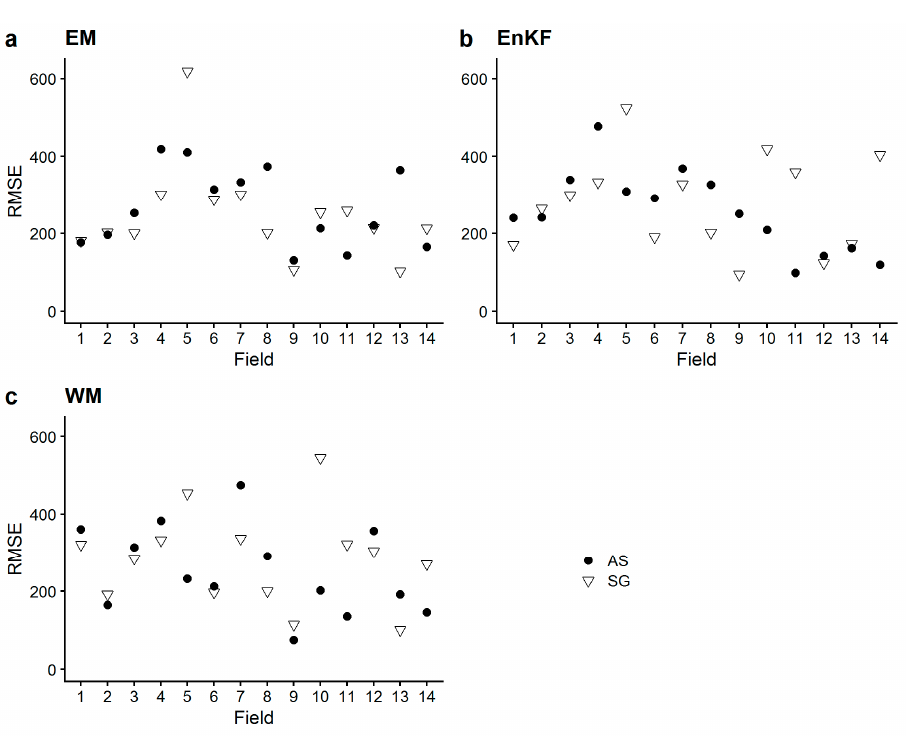
Figure 6. RMSE calculated from measured vs. predicted biomass in all sampling points per field, for analyzed soil texture (AS) as model input and SoilGrids-extracted (SG) soil texture as model input. ( a ) Results for ensemble mean (EM); ( b ) results for ensemble Kalman filter (EnKF); ( c ) results for weighted mean (WM). All values in g m − 2 .